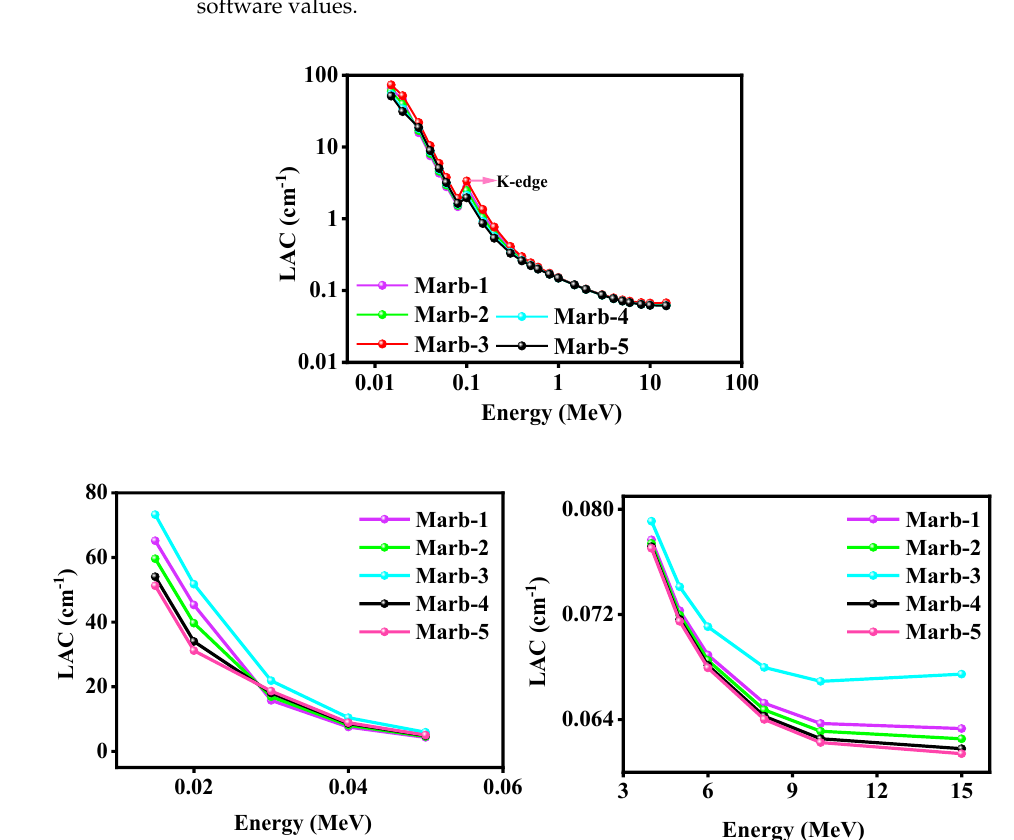
Figure 5. Demonstration of the LAC of the prepared composites.